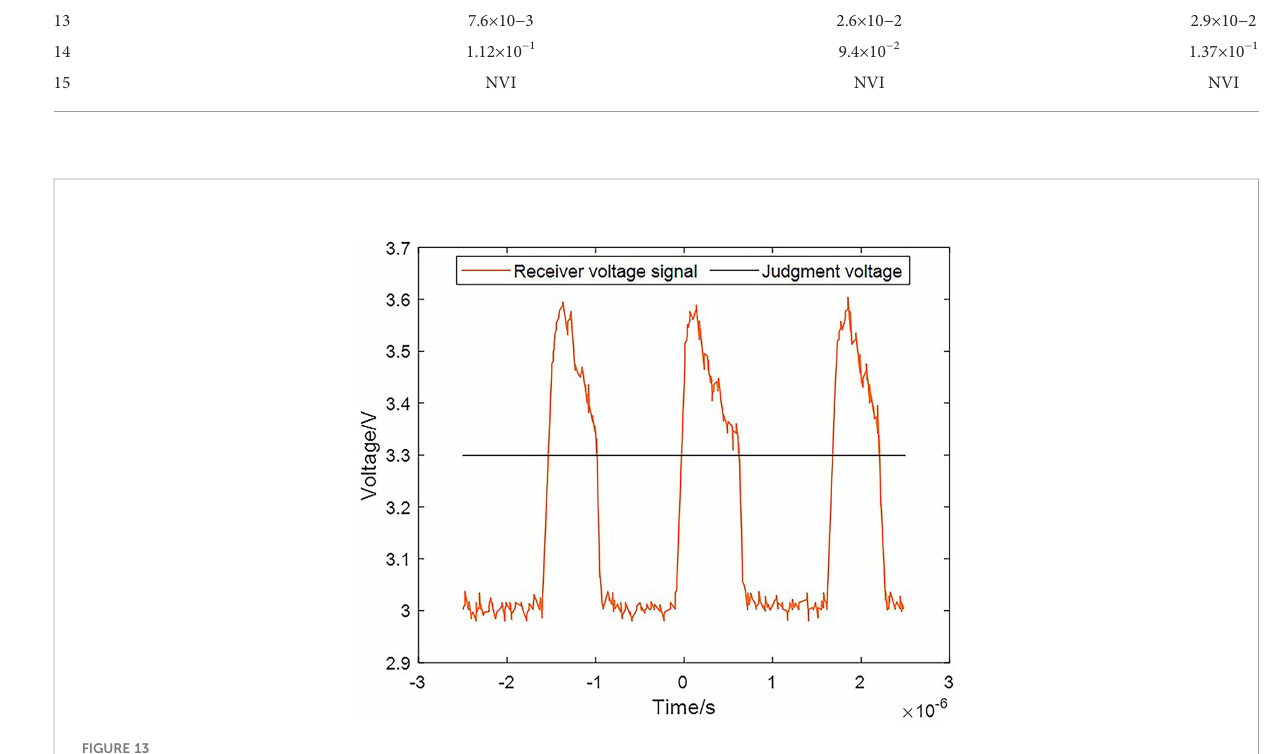
FIGURE 13 Optical pulse signal at a distance of 13 m.